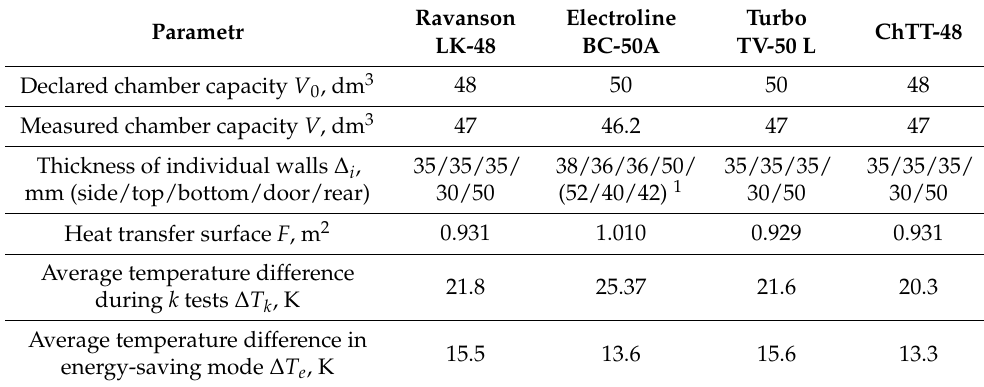
Figure 1. Examined thermoelectric refrigerators (from the left): Ravanson LK-48, Electroline BC-50A, Turbo TV-50L, ChTT-48. Table 2. Selected parameters of the examined thermoelectric refrigerators.